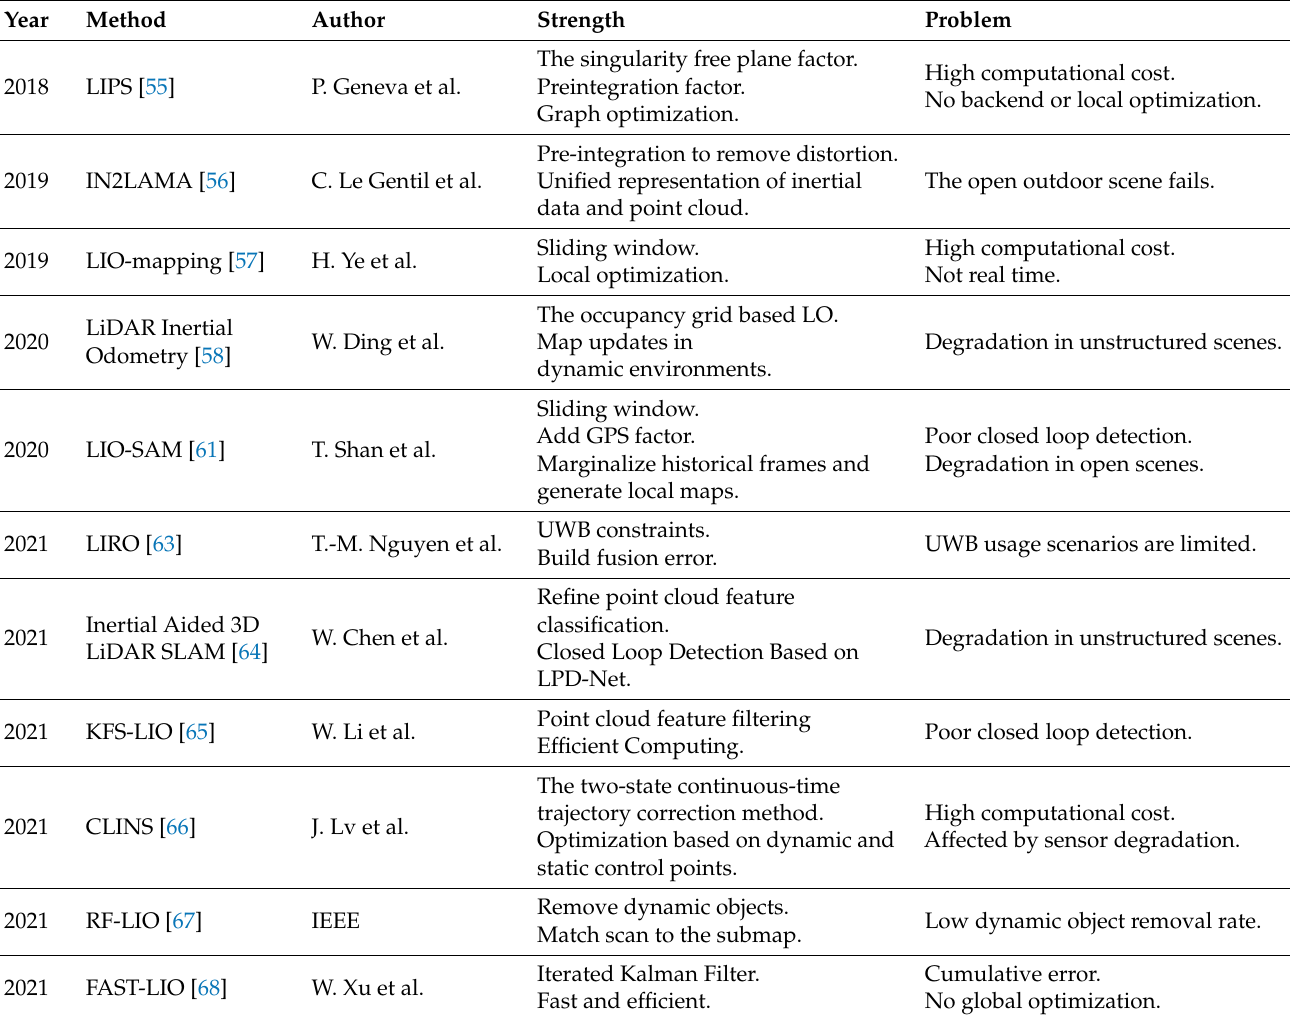
Table 4. LI tightly coupled